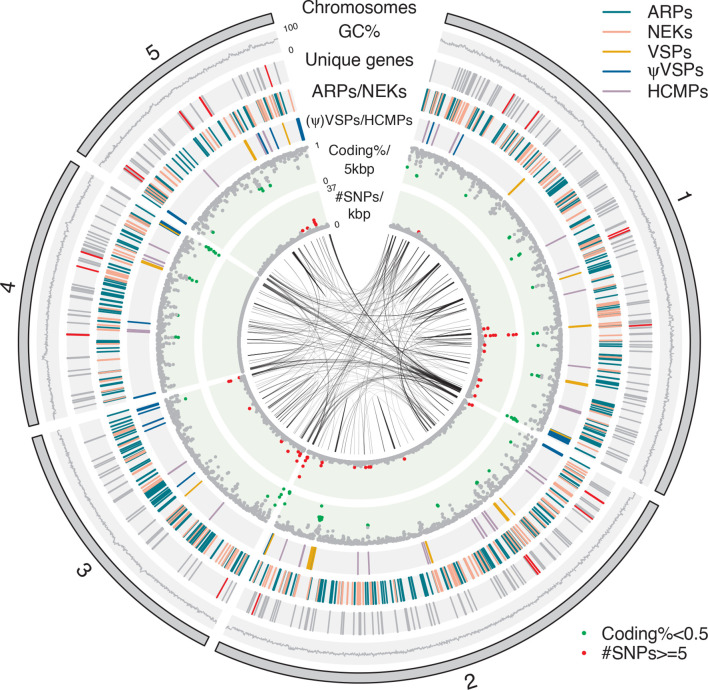
Circular representation of the G. muris chromosomes. From outside inward: five chromosomes, GC percent, unique genes (grey) including unique metabolic genes in Table 4 (red), ARPs (greenblue) / NEKs (pink), VSPs (orange) / ψVSPs (blue) / HCMPs (purple), Coding percent / 5 kbp (green if <=0.5), # SNPs / kbp >=5 (red), blastn matches with >95 % identity and >1000 bp in size. The circular plot was drawn with circlize [94].